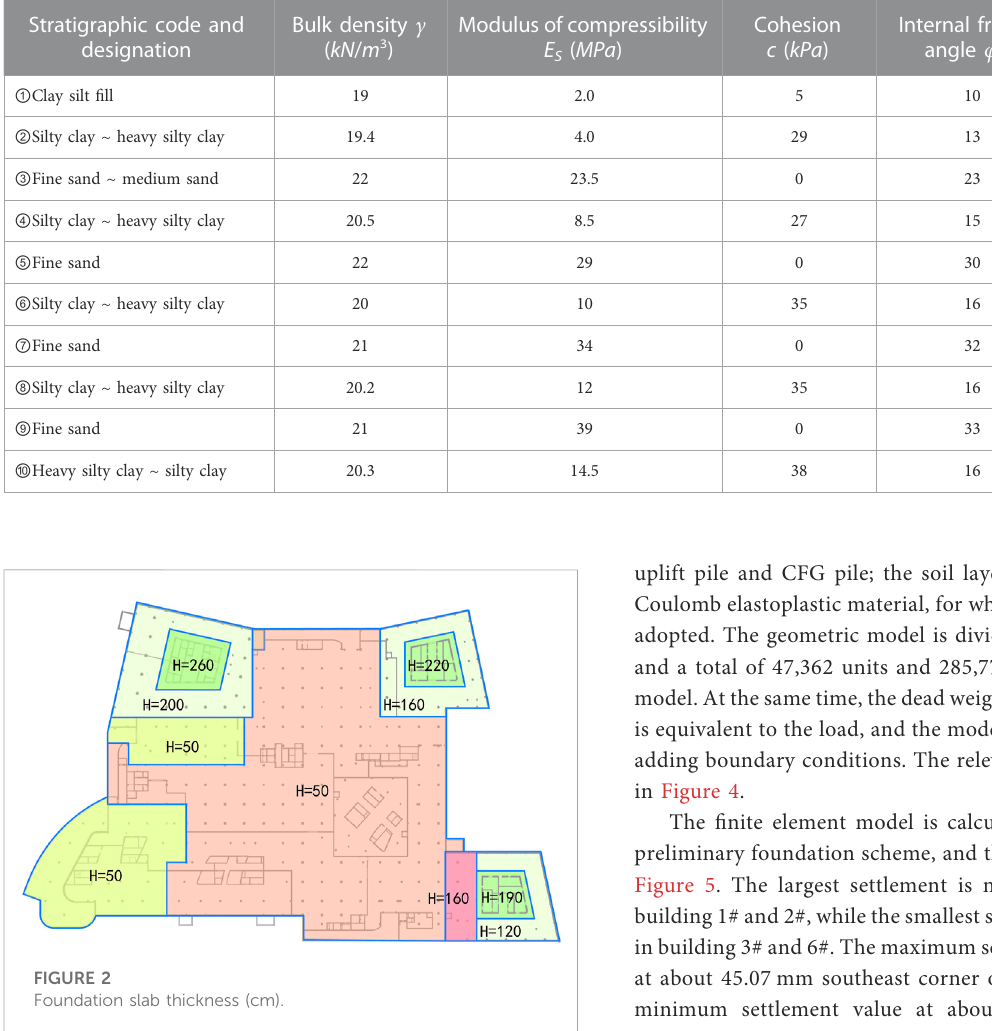
TABLE 2 Main physical and mechanical indexes of soil layer.